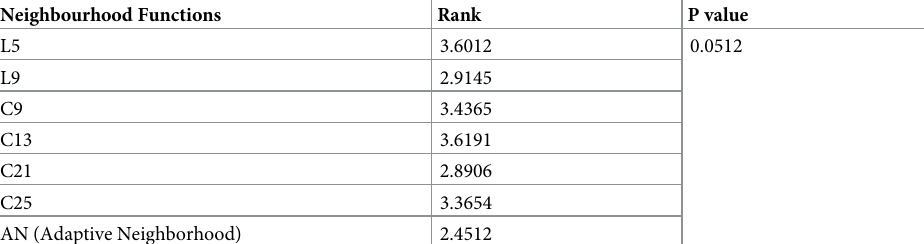
Table 8. Friedman test result for individual ranking and P-value.